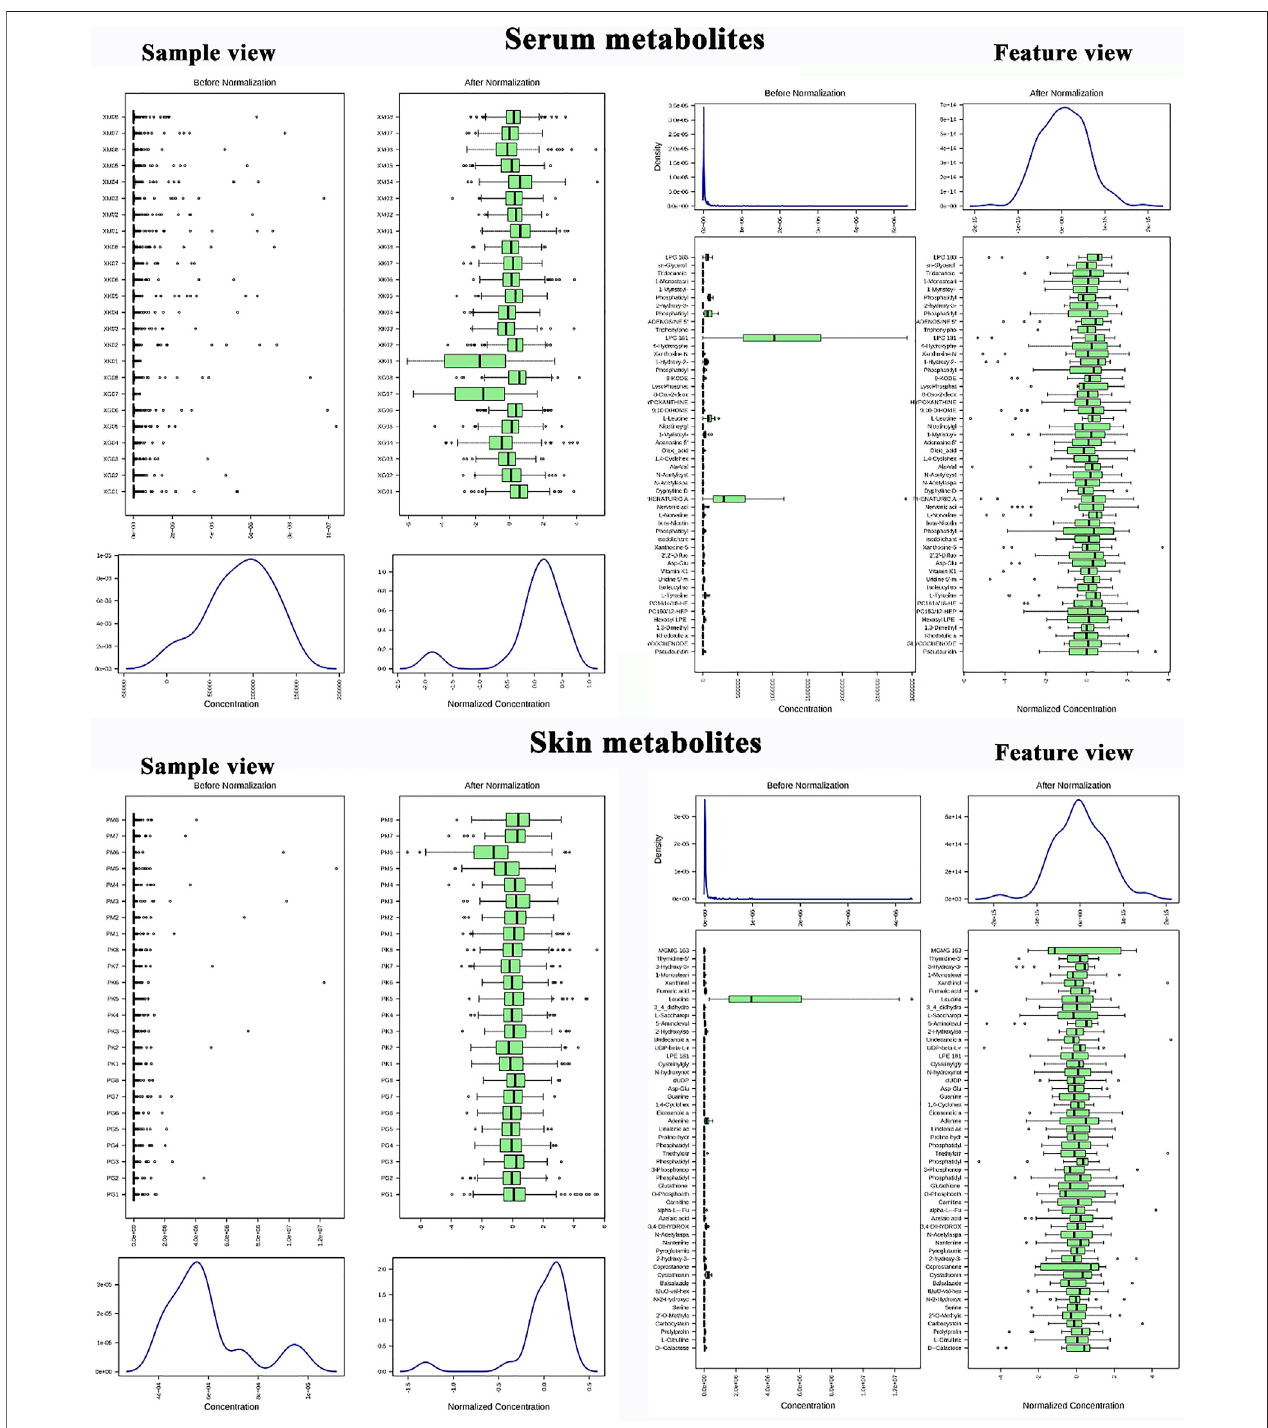
FIGURE 3 | Metabolomics data preprocessing; Skin metabolite data before and after normalization (sample feature view); Serum metabolite data before and after normalization (sample feature view).